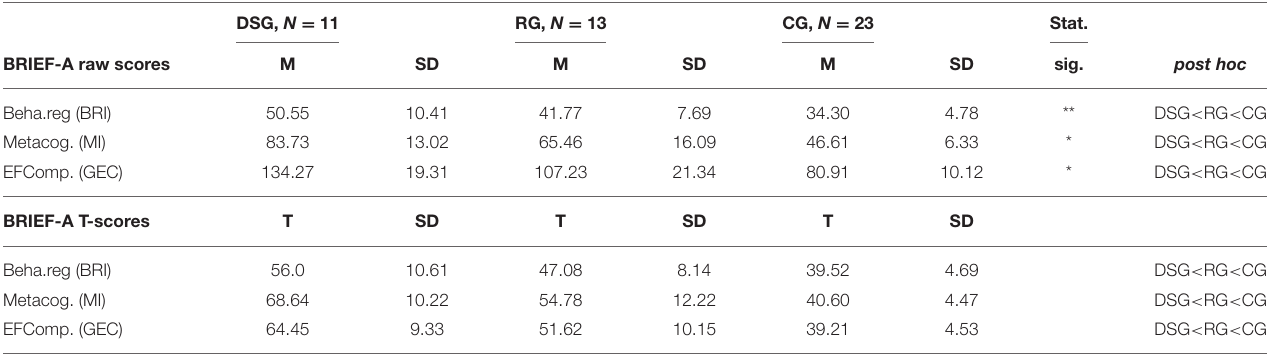
TABLE 4 | Self-reported EF impairment for the Depressed Symptom Group (DSG); MADRS* > 9, Remitted Group (RG); MADRS* ≤ 9) and the Control Group (CG); MADRS* N/A. DSG, N = 11 RG, N = 13 CG, N = 23